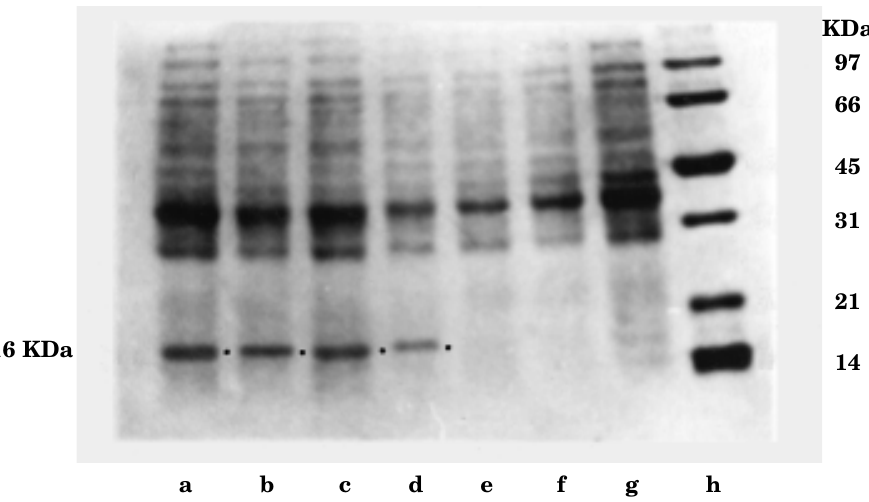
1. SDS-PAGE of proteins extracted from cowpea plants. Acidic PR proteins were extracted from leaves on day 2 after the 2nd treatment. Separated proteins were stained with Coomassie Blue. Lane a, inoculated and treated with salicylic acid containing Tween; lane b, inoculated and treated with salicylic acid; lane c, uninoculated and treated with salicylic acid containing Tween; lane d, uninoculated and treated with salicylic acid; lane e, inoculated and treated with Tween; lane f, inoculated untreated; lane g, uninoculated untreated; lane h, molecular weight marker. The induced band is indicated with a dot to the right of the respective